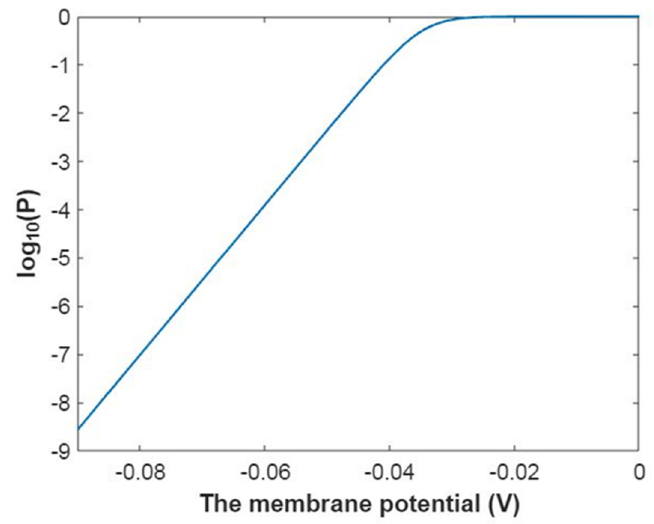
Figure 17. The relationship between the membrane potential and the common logarithm of the open probability of potassium channels at G = − 5.35 J and over a membrane potential range from − 0.09 V to 0 V.